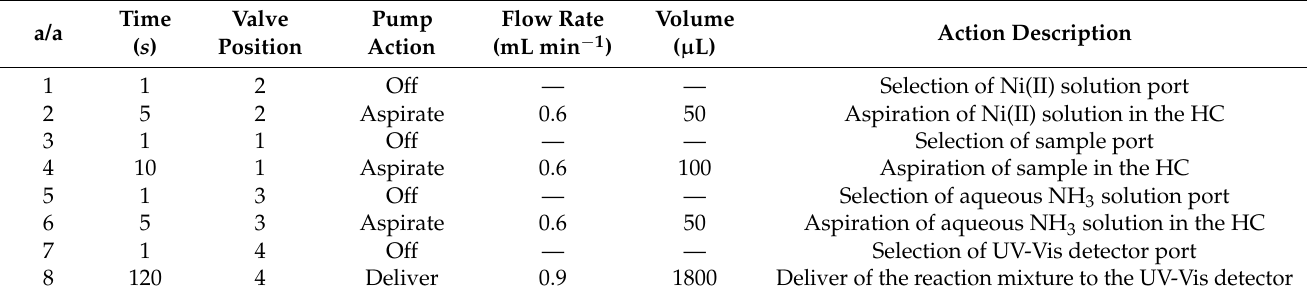
Table 3. ZF sequence for the automated determination of captopril in the in vitro dissolution